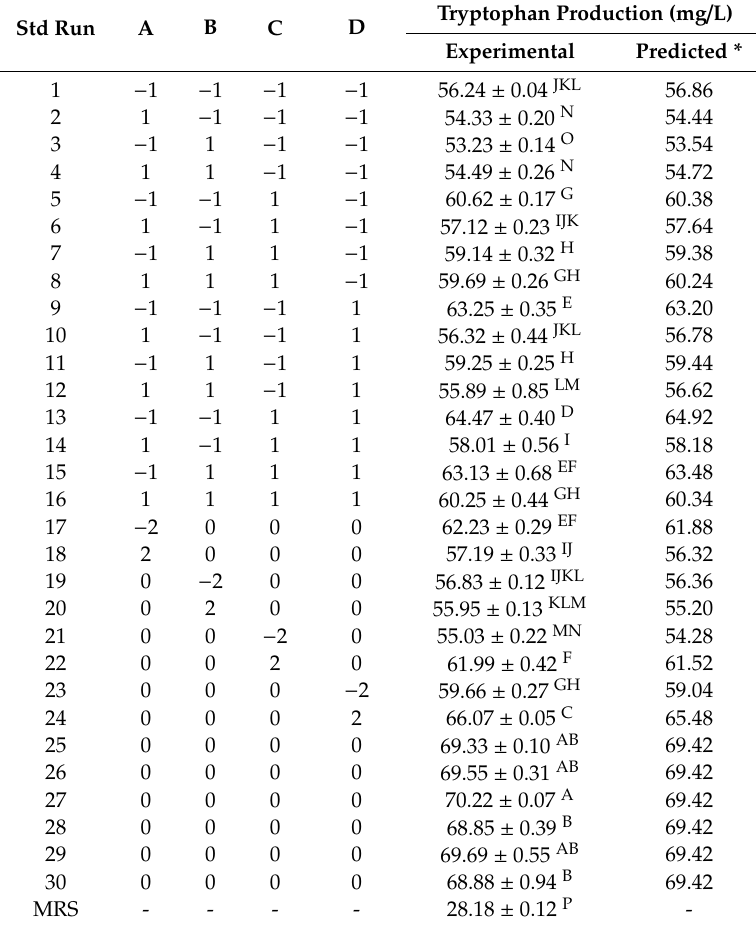
Table 6. Central Composite Design (CCD) matrix with coded value and their corresponding experimental and predicted tryptophan production by P. acidilactici